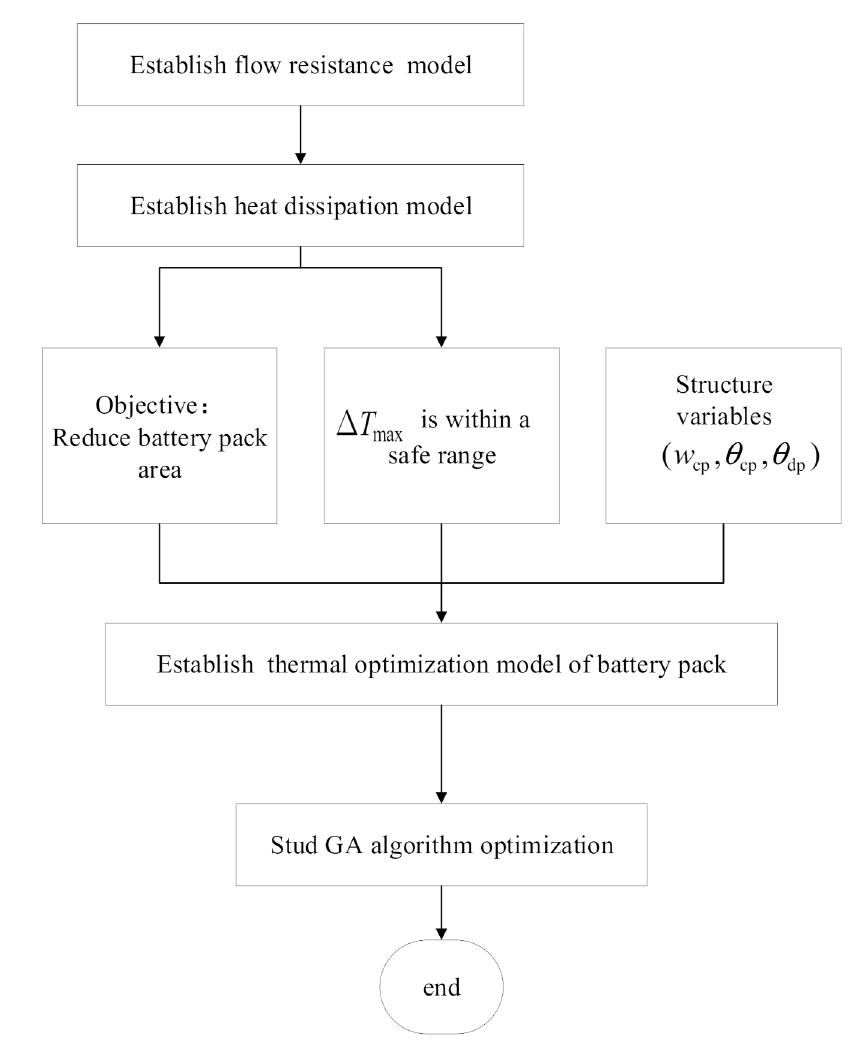
Figure 14. Flow chart of battery pack